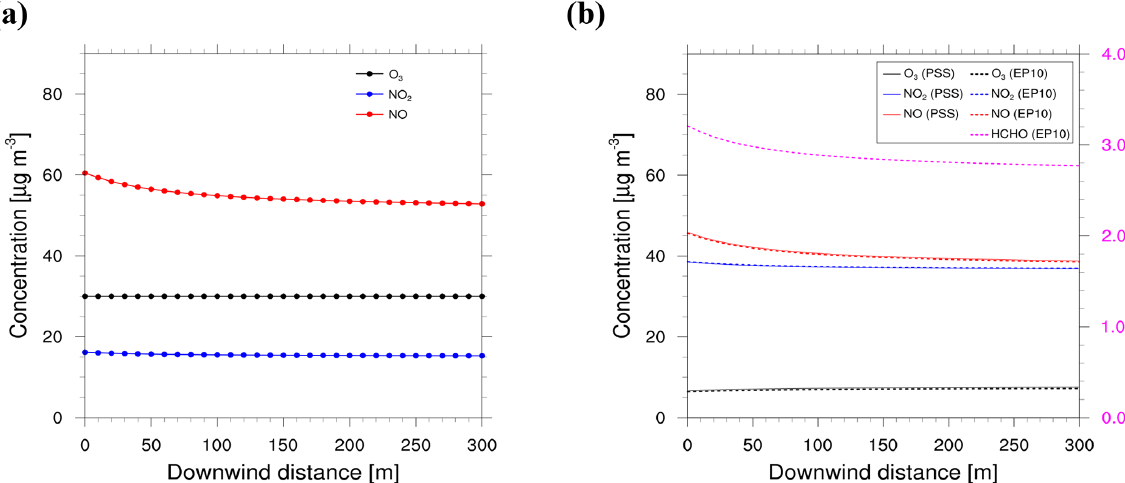
Figure 4. Photochemistry downwind of a line source in the SE–NW diagonal of the 1 × 1km 2 grid cell: (a) concentration of O 3 (black), NO (red), NO 2 (blue) with no chemistry (lines with filled circles), and (b) O 3 , NO, NO 2 and HCHO (magenta, second y axis) with PSS (solid lines) and EP10-Plume (dashed lines and magenta line). Note that lines for PSS and EP10-Plume are overlapping for O 3 , NO and NO 2